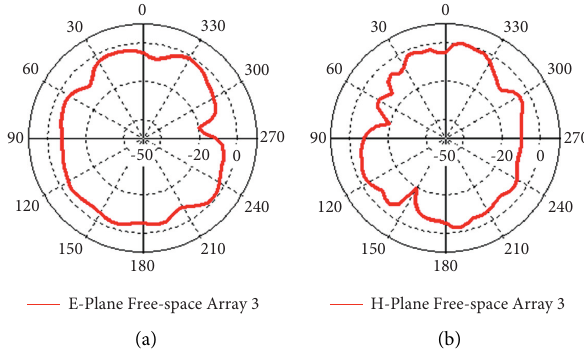
Figure 13: Radiation pattern of Array 3. (a) E-plane radiation pattern at 60GHz. (b) H-plane radiation pattern at 60GHz.